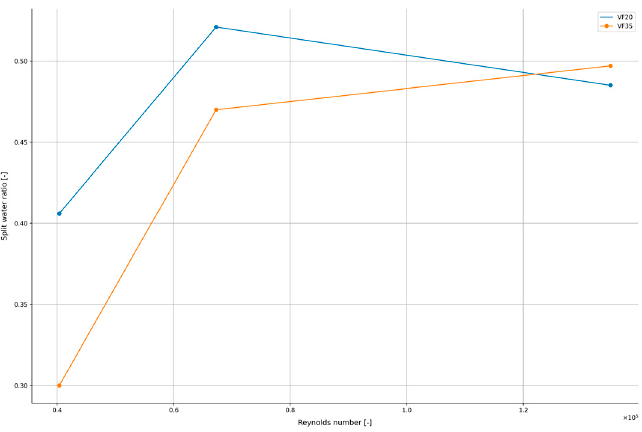
Figure 10. Progression of the split water ratio over the Reynolds number for two extreme